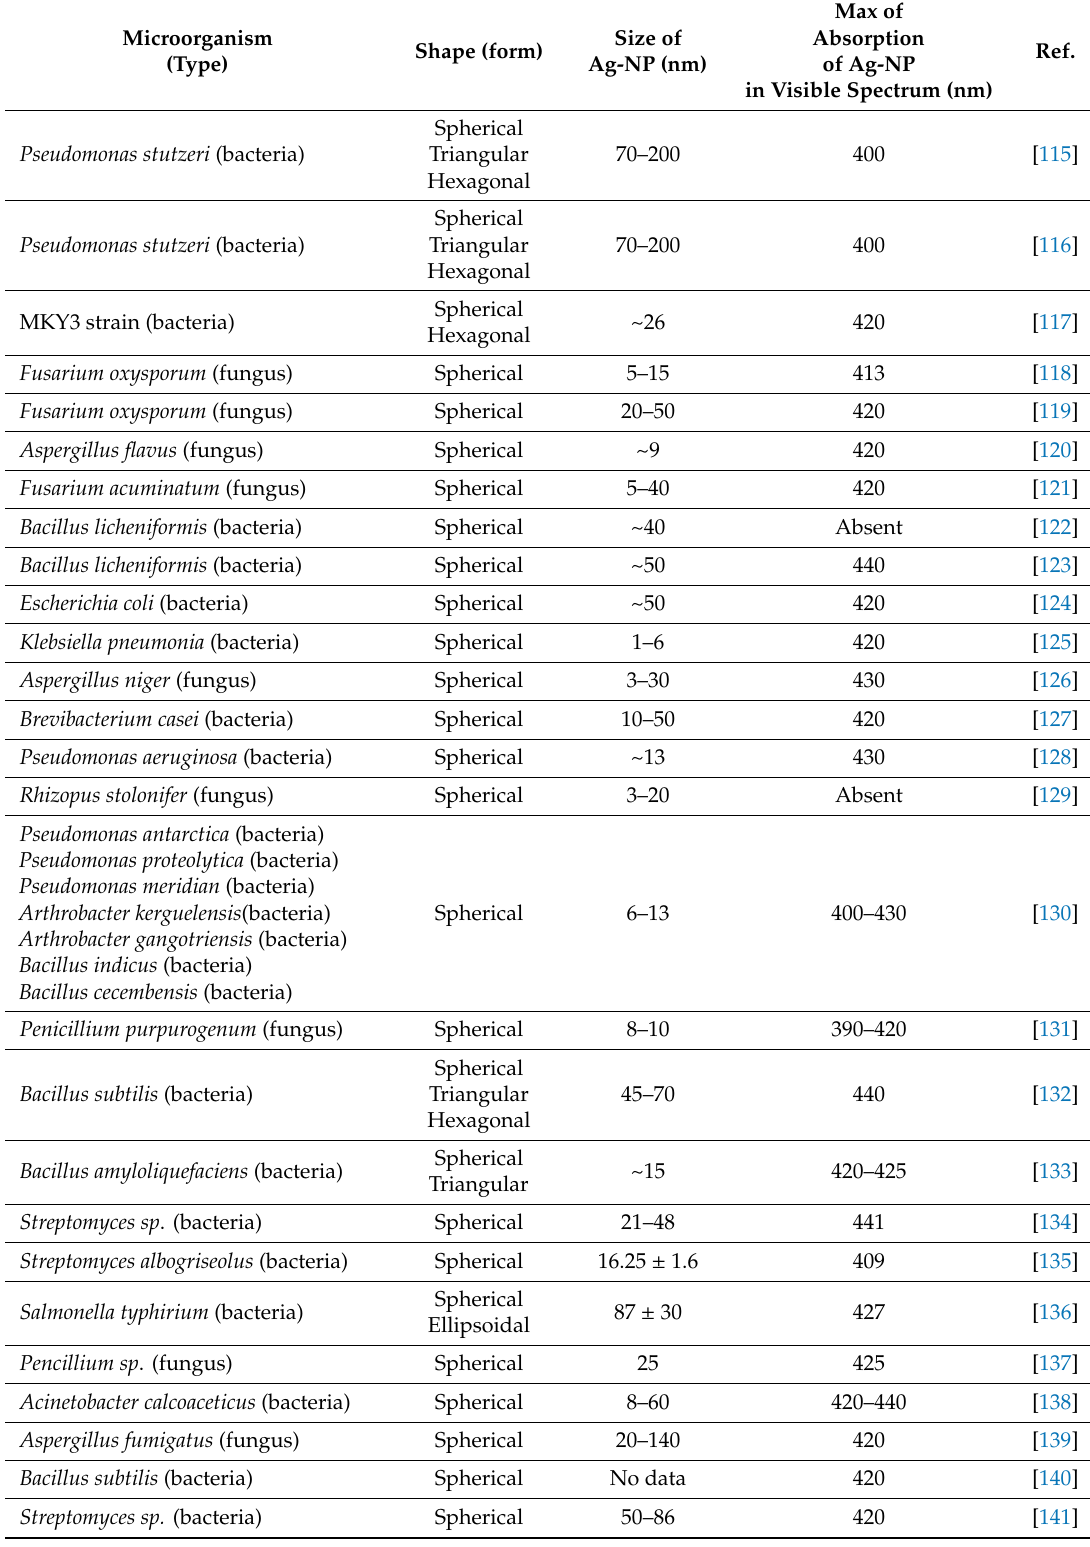
Table 2. Sizes and shapes of Ag-NP received by “green synthesis” by using various microorganisms.